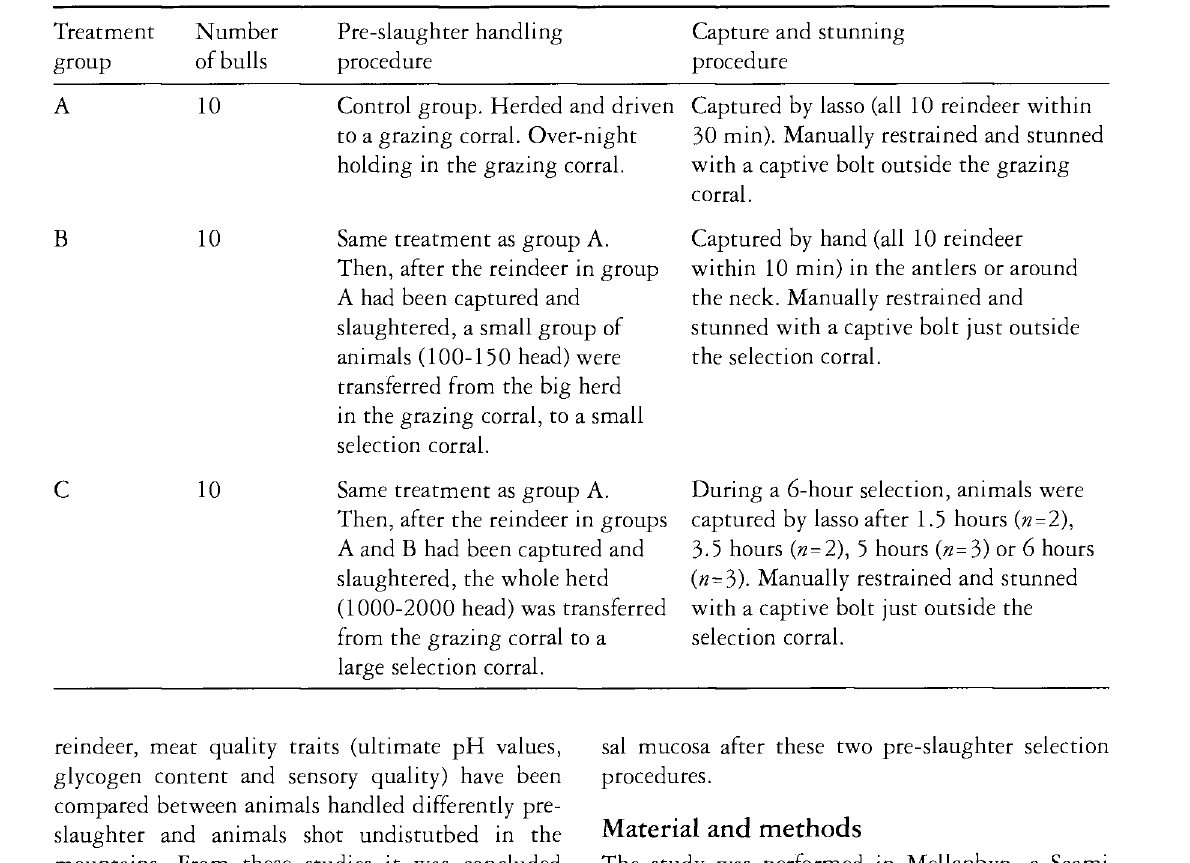
Table 1. Characteristics of various treatment groups of reindeer included in the